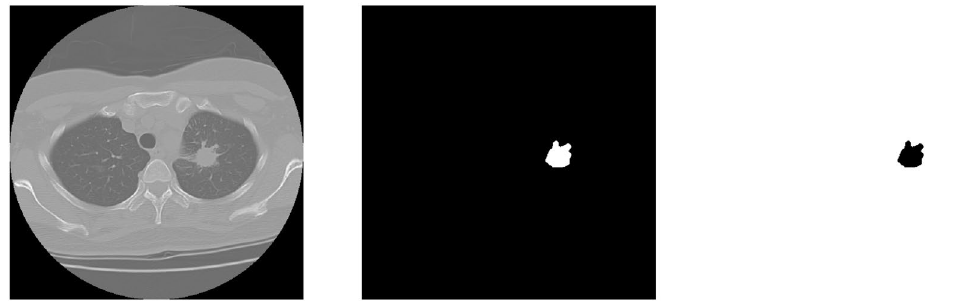
Figure 6. Inverting the pulmonary label. From left to right, CT image, original label, complementary label.